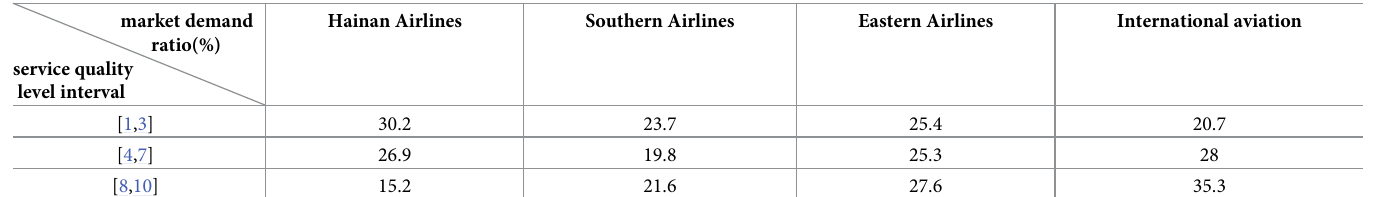
Table 1. Market share of different